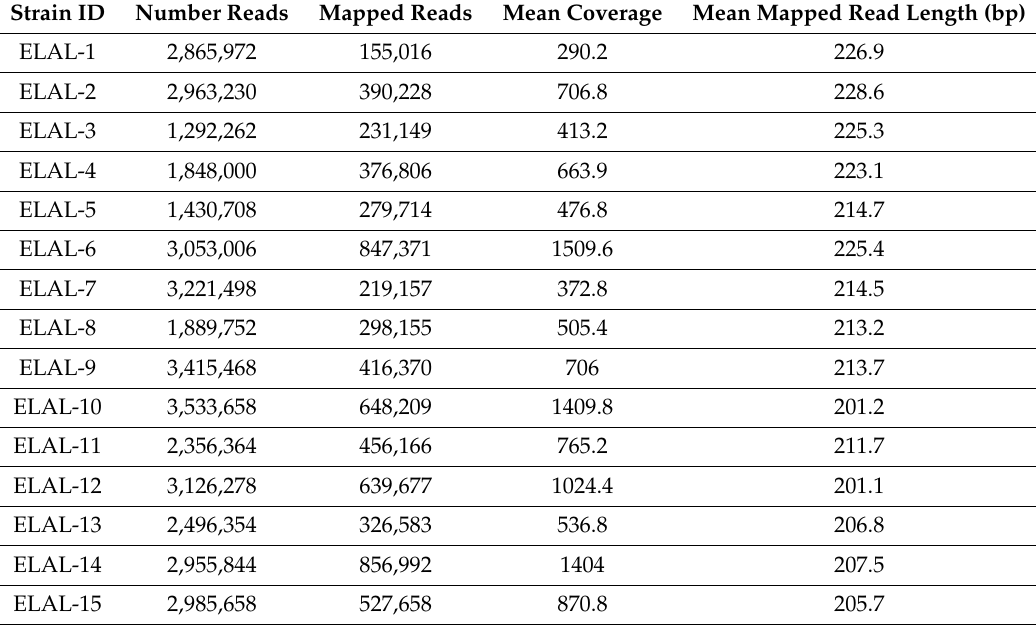
Table 2. Sequencing details of sequenced CHV-1